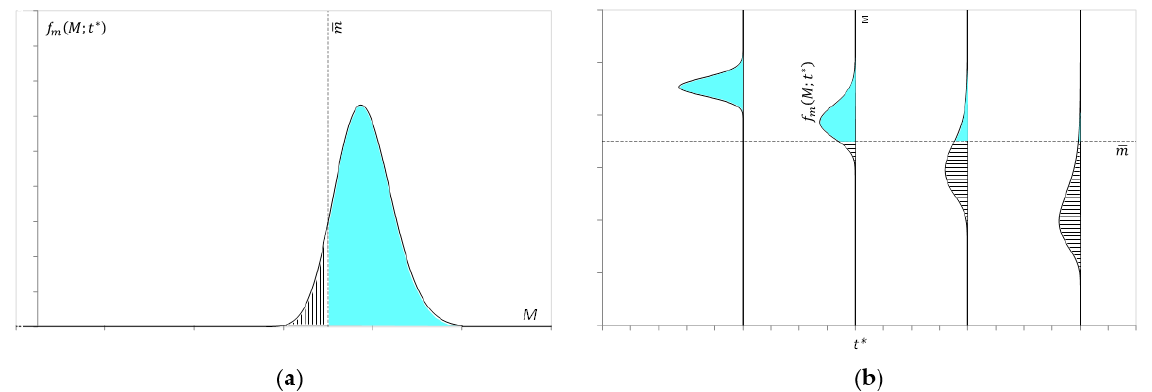
Figure 1. Probability of reaching or crossing the threshold m : the dotted area is the probability of reaching the threshold m and defined by the cumulative distribution F m ( M , t ∗ ) ; the solid colour area is the probability of exceeding the threshold m and defined by the survey function ℑ m ( M , t ∗ ) . ( a ) probability density function (p.d.f.) built for an instant t *; ( b ) p.d.f. built for every instant t * investigated.